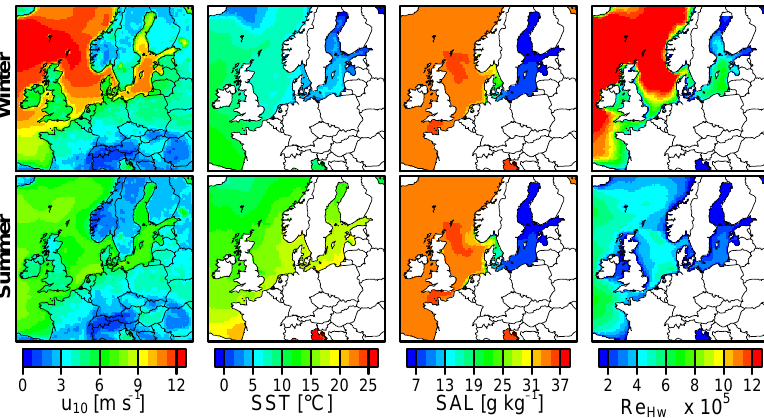
Figure 4. The 2-month average u 10 , SST, SAL, and Re Hw data are plotted for winter (top) and summer (bottom). Re Hw was calculated according to Eq.